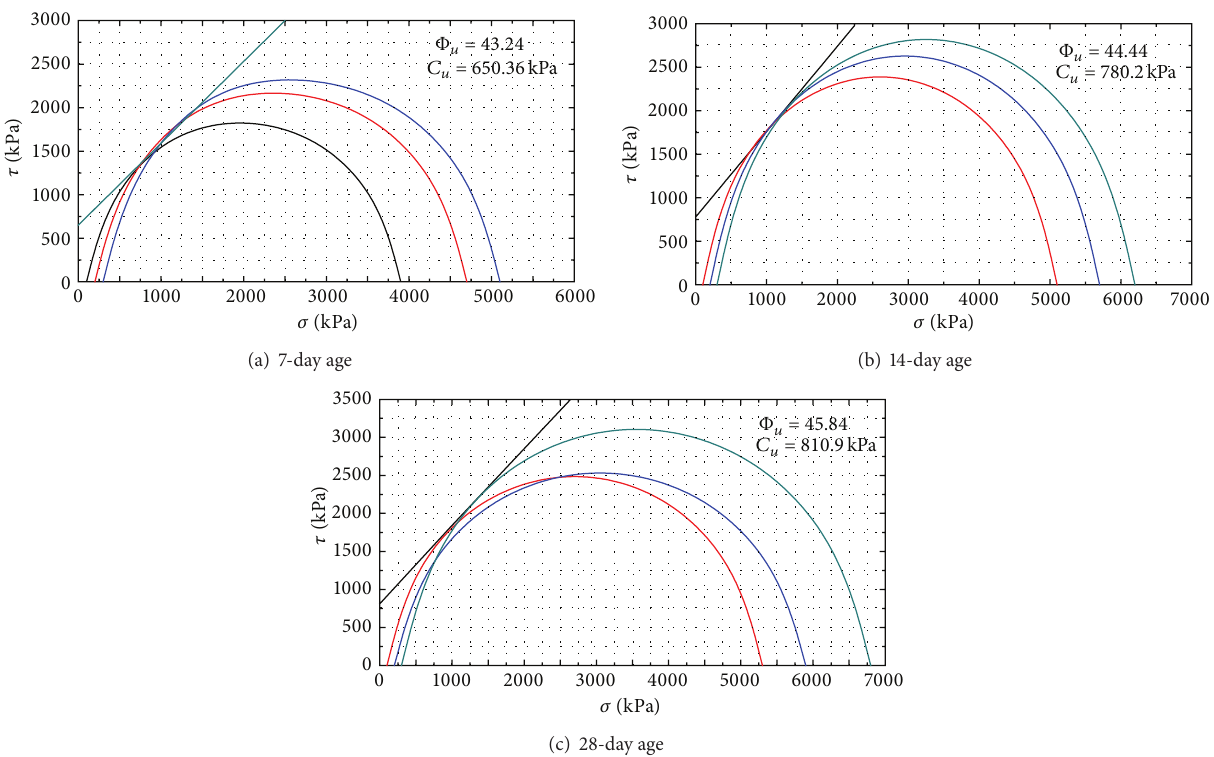
Figure 7: Polypropylene fiber content 0% unconsolidation undrained shear strength envelope.